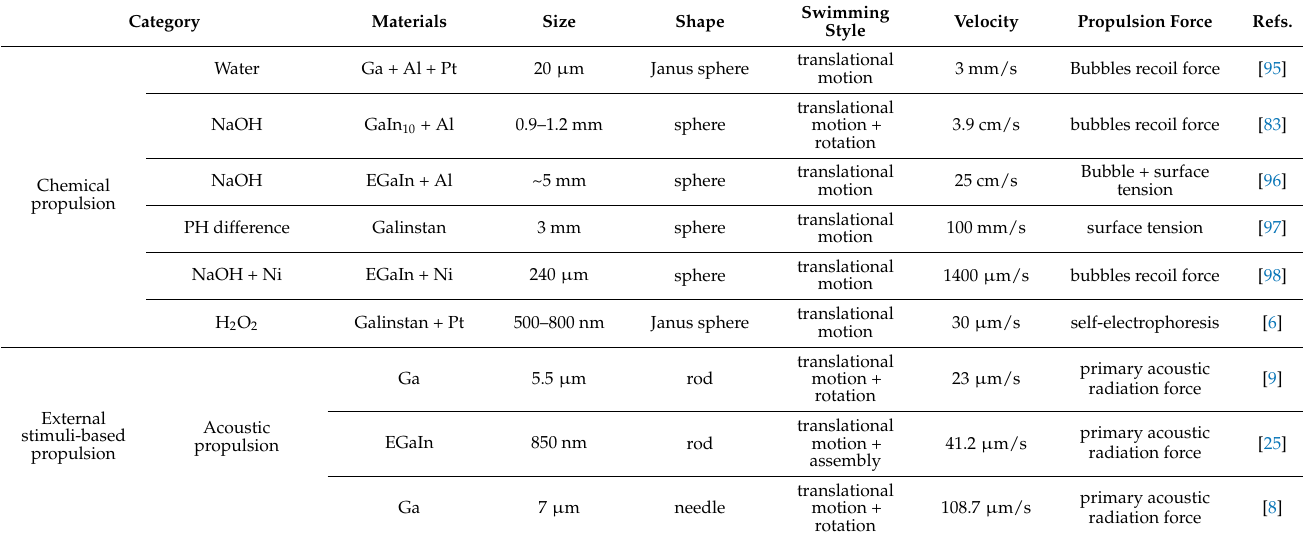
Table 5. Propulsion mechanism and performance of different types of